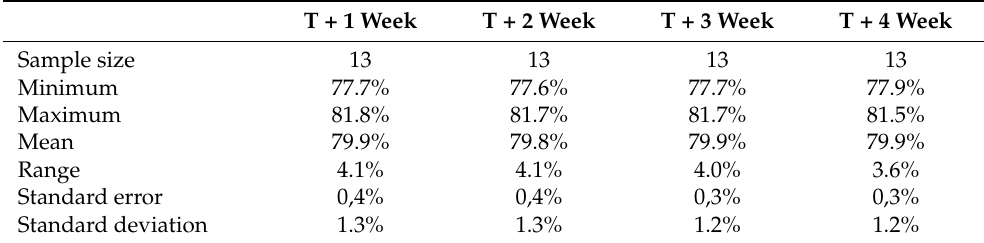
Table 7. Descriptive statistics for target ‐ oriented OEE prediction based on decision tree.